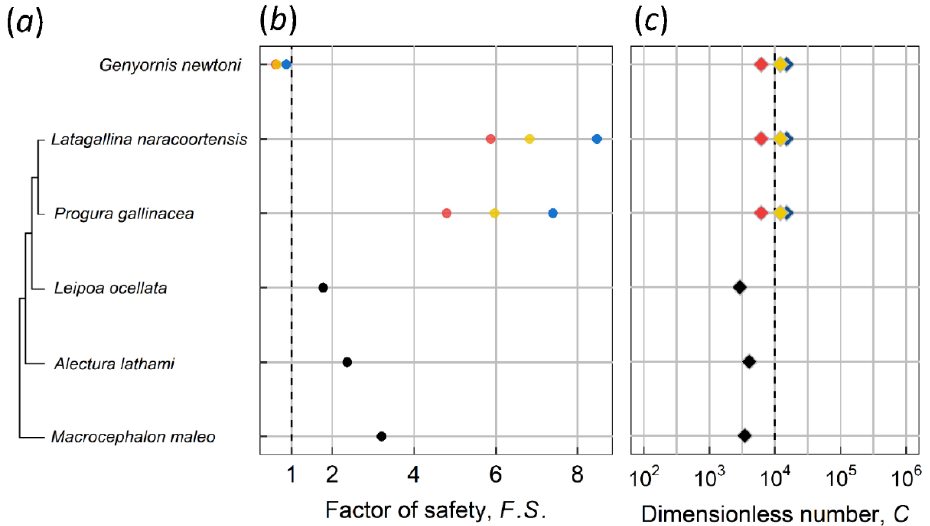
Figure 6. Factor of safety F.S. , C number and the phylogenetic relationship of megapodes and Genyornis newtoni . ( a ) phylogenetic tree of megapodes is based on Shute et al. [34]. ( b ) F.S. of extinct species were calculated with Williams’ egg (red), Spooner egg (blue), and additional specimen (yellow), respectively. Extant megapodes are illustrated as black dots. ( c ) different colors of C number indicate identical implication of F.S. Table 3. Similar eggshell geometries with PGOM (putative Genyornis oological material). Data were published by Juang et al. [3]. The bold text indicates similarity to the Spooner egg <15%. (Length: 126 mm, width: 97 mm). Common Species Name Diomedea